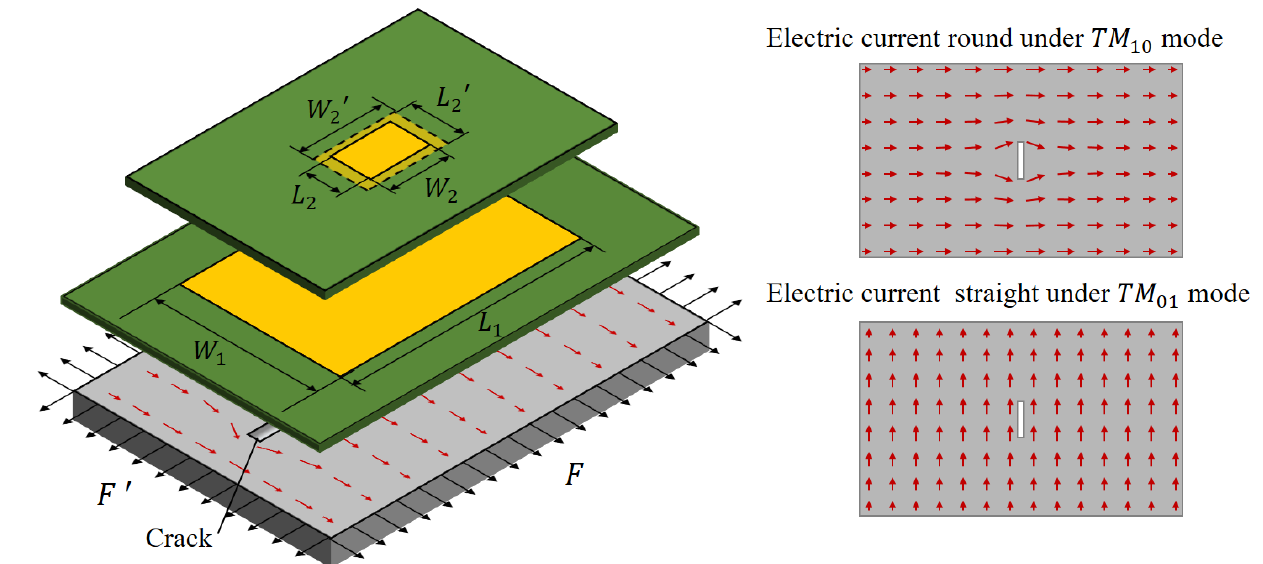
Figure 2. Schematic diagram showing working principle of multilayer patch antenna sensor.